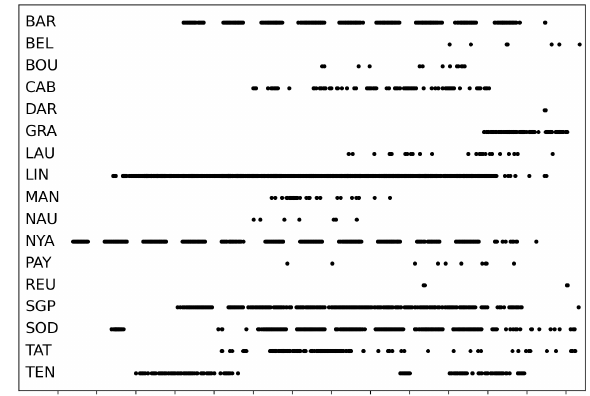
Figure B5. Time of the available sonde flights (with SZA < 85 ◦ ) for the GRUAN stations considered in this study. For station names and further details see Table